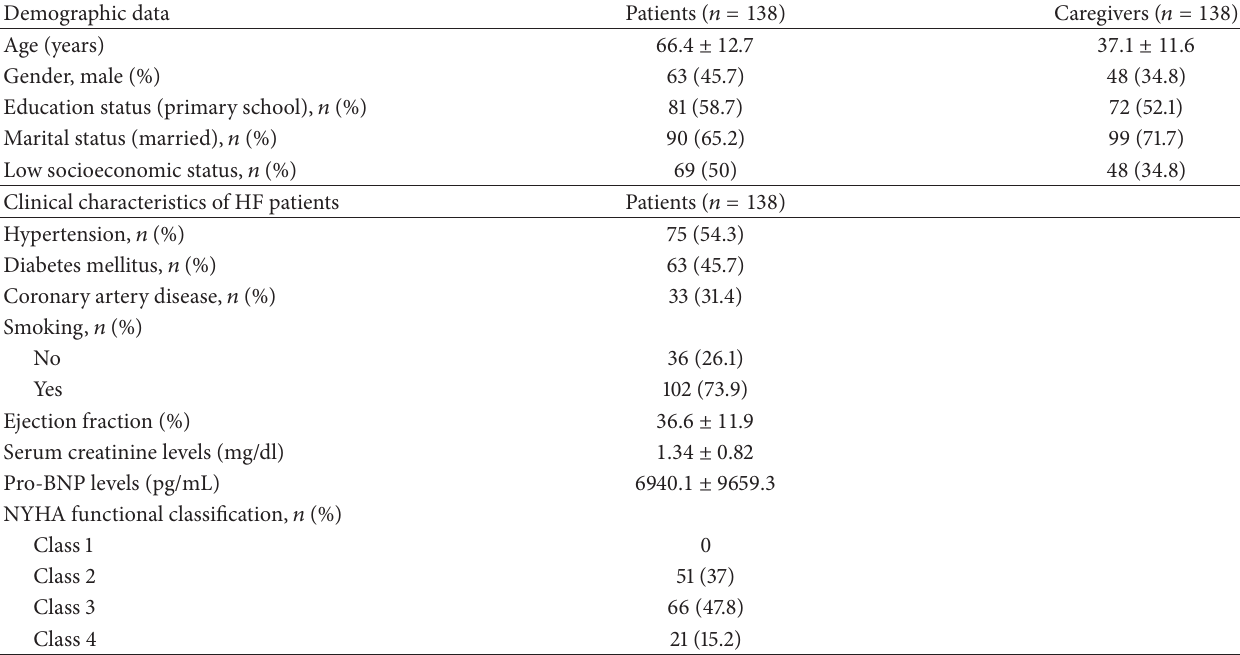
Table 1: Clinical characteristics and demographic data of study population.